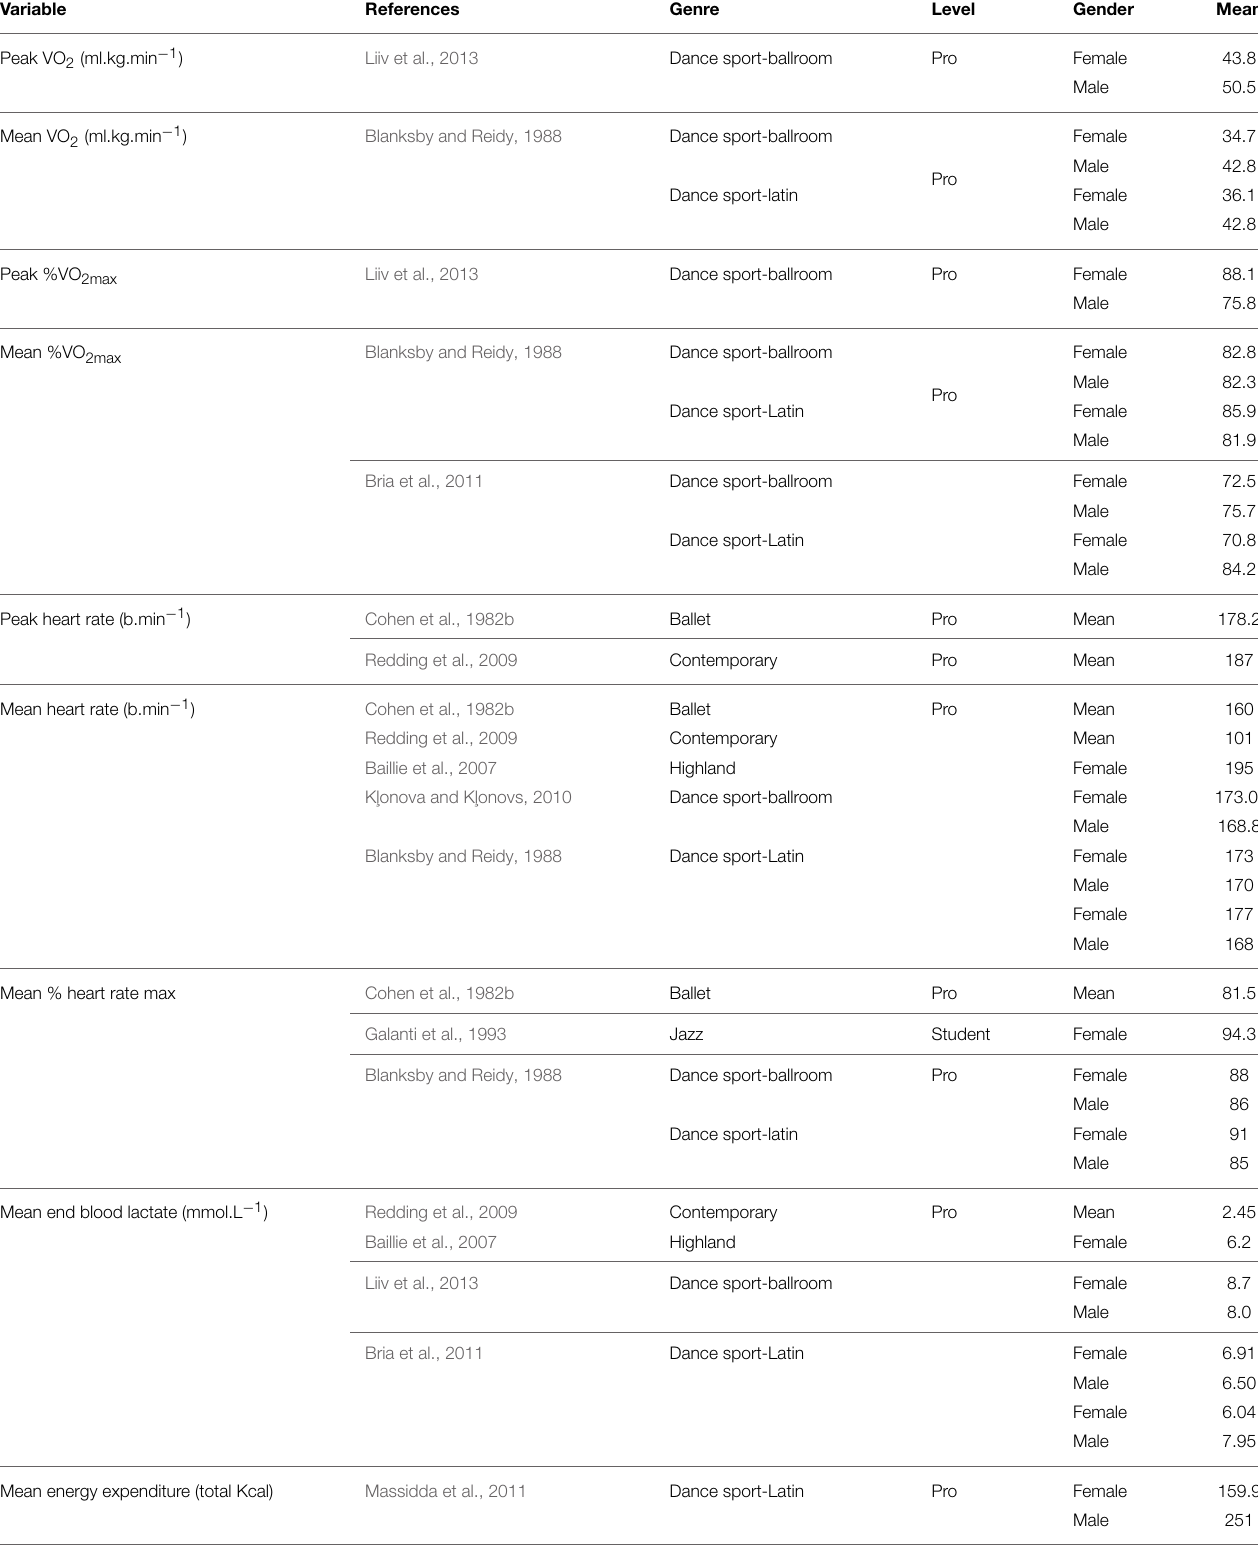
TABLE 4 | Mean data of studies examining the demand of dance performance and/or competition.